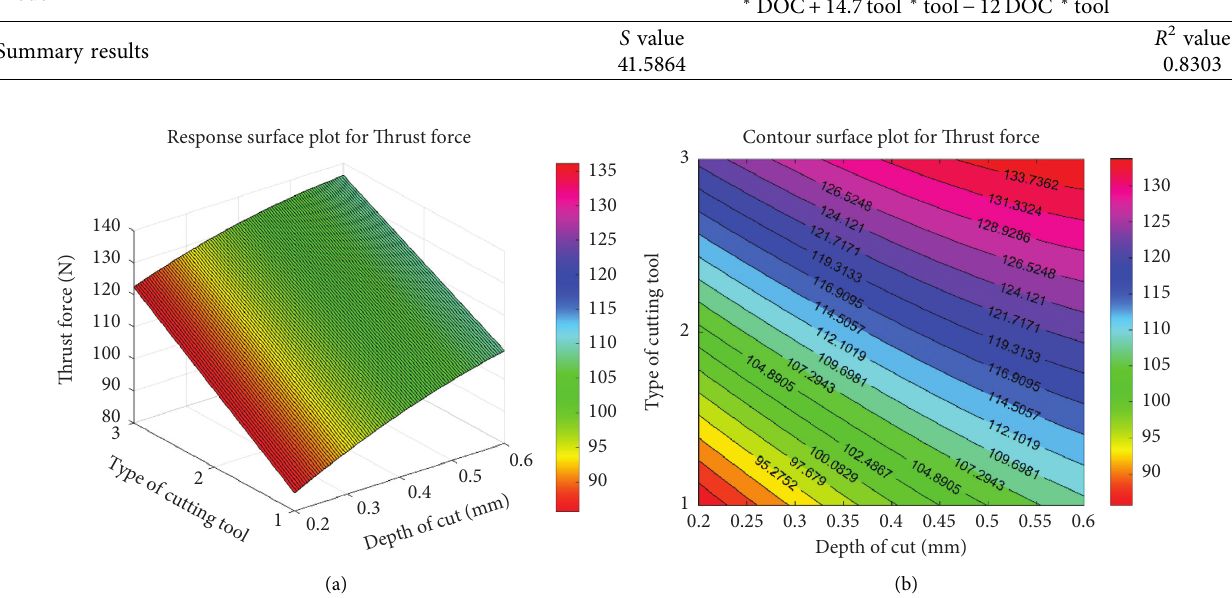
Figure 11: (a) Response surface plot for Thrust force (cutting tool-type vs. cutting speed). (b) Contour surface plot for Thrust force (cutting tool-type vs. cutting speed). Table 16: Regression model and summary results for Thrust force. Model